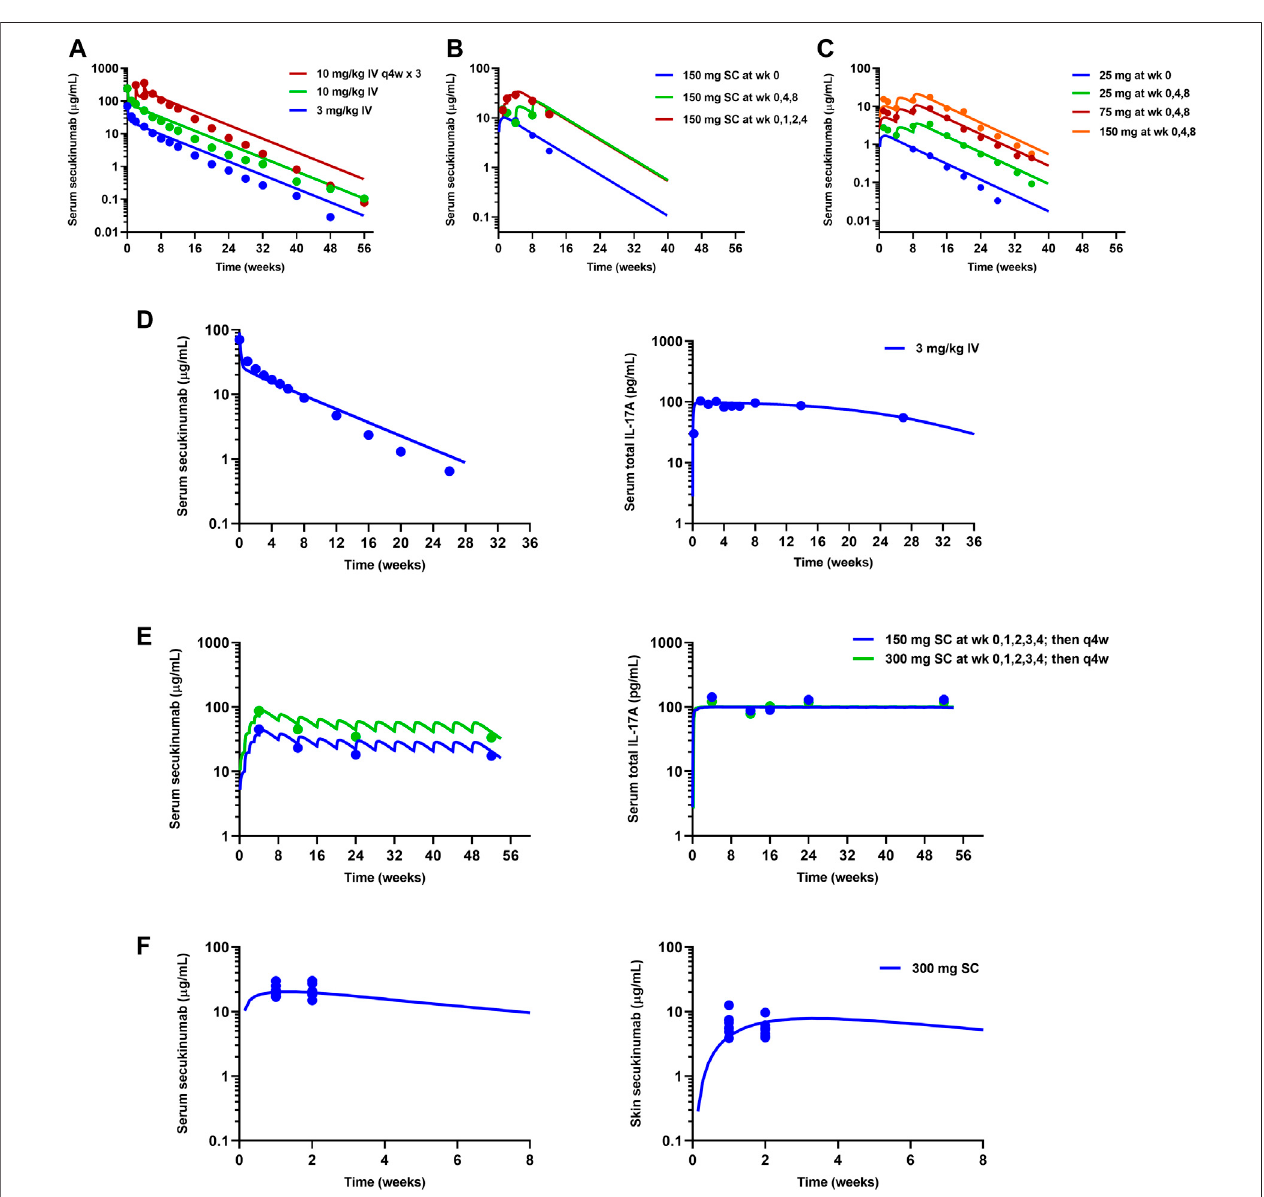
FIGURE 3 | Model fi tting of observed mean data in clinical trials for secukinumab. Refer to Table 1 for details on each clinical study. (A) High dose-ranging study (Rich et al., 2013). (B) SC dose regimen- fi nding study (Rich et al., 2013). (C) SC low dose-ranging study (Papp et al., 2013). (D) Proof-of-concept study (FDA, 2015). (E) Phase 3 studies (Langley et al., 2014; FDA, 2015). (F) Exploratory biodistribution study (Dragatin et al., 2016). Solid lines represent model- fi tted pro fi les, whereas symbols indicate observed mean